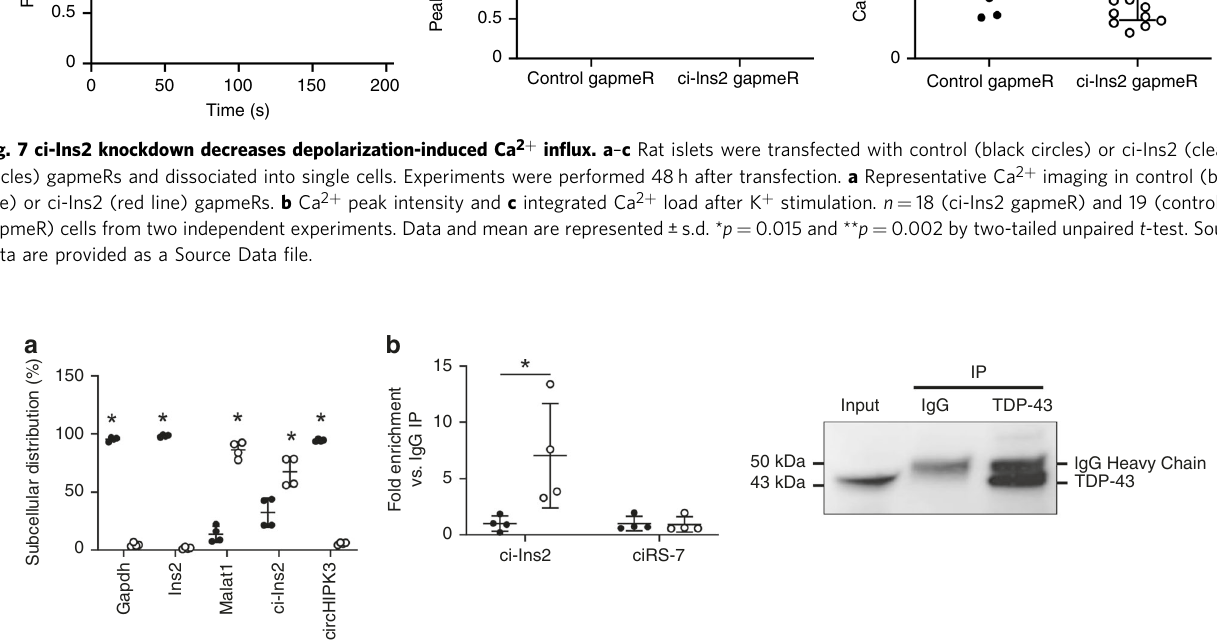
Fig. 8 ci-Ins2 predominantly localizes to the nucleus and interacts with the RBP TDP-43. a Expression level of indicated genes, measured by qPCR, in nuclear (clear circles) and cytosolic fractions (black circles) of MIN6B1 cells. n = 4 independent experiments. b RNA immunoprecipitation (IP) of TDP-43 or control IgG in MIN6B1 cell lysates. Left : ci-Ins2 and ciRS-7 RNA levels, measured by qPCR, in immunoprecipitated samples relative to IgG. TDP-43 IP (clear circles) and IgG IP (black circles). n = 4 independent experiments. Right: Representative image of immunoprecipitated samples immunoblotted for TDP-43. Data and mean are represented ± s.d. * p ≤ 0.01 ( a ) and * p = 0.04 ( b ) by two-tailed unpaired t -test. Source data are provided as a Source Data fi